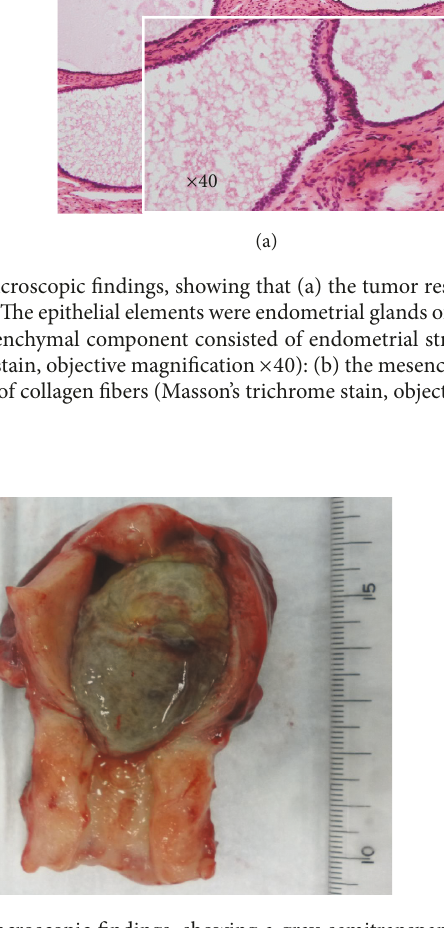
Figure 5: Macroscopic findings, showing a gray-semitransparent- edematous necrotic tumor, measuring approximately 4 × 2.5 cm, in the uterine cavity. The attached area could not be